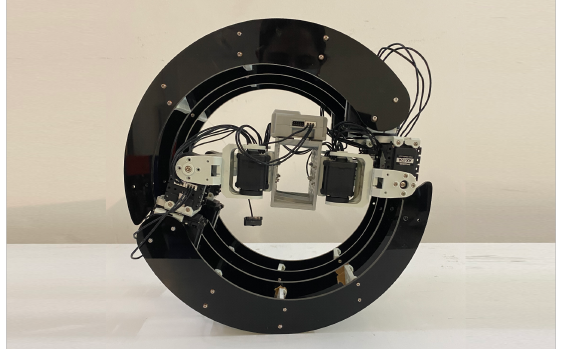
Figure 5. Rolling configuration.